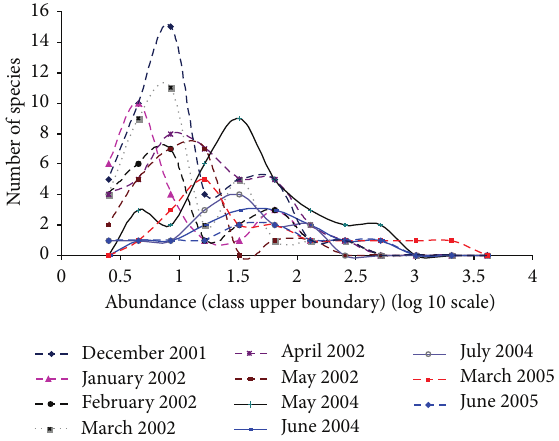
Figure 4: Frequency of species in relation to abundance in the different sampling months.